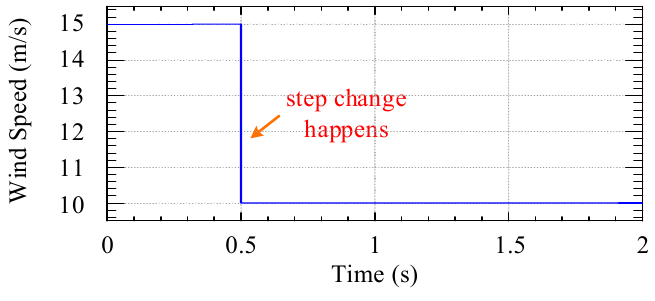
Figure 13. Wind speed step change at t = 0.5 s.